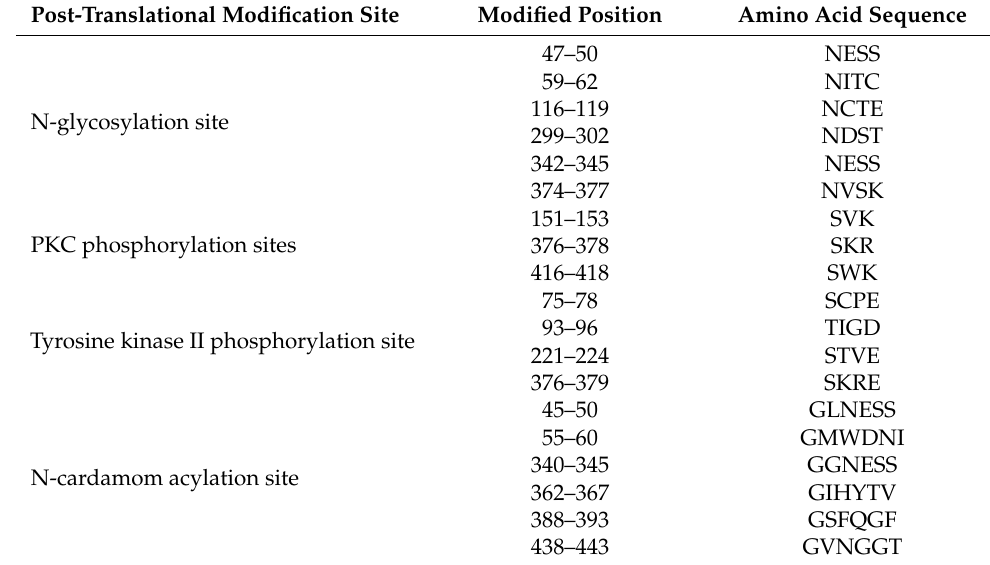
Table 2. Post-translational modification site of PAC1R.